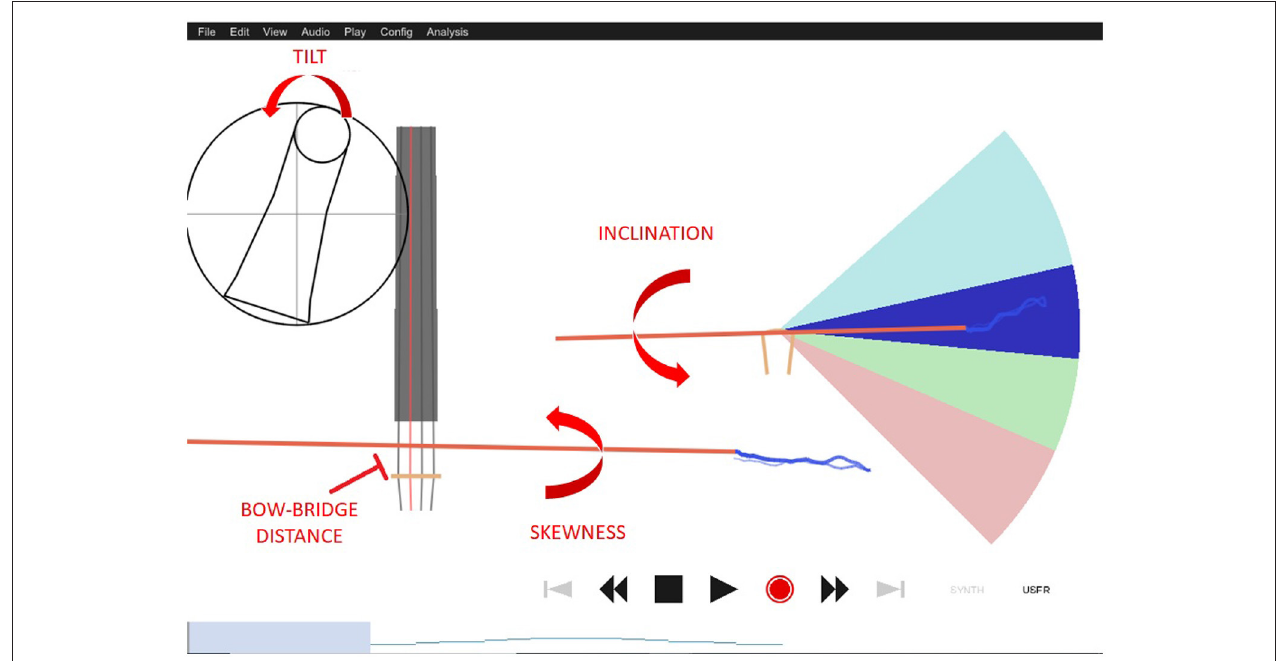
FIGURE 4 | Visual display of the tool used to offer real-time feedback on motion and kinematics to participants. From the display, we can infer some of the descriptors that will be computed later on. The value of skewness, for example, is close to 0 when the bow remains perpendicular to the strings as is the case in this figure.